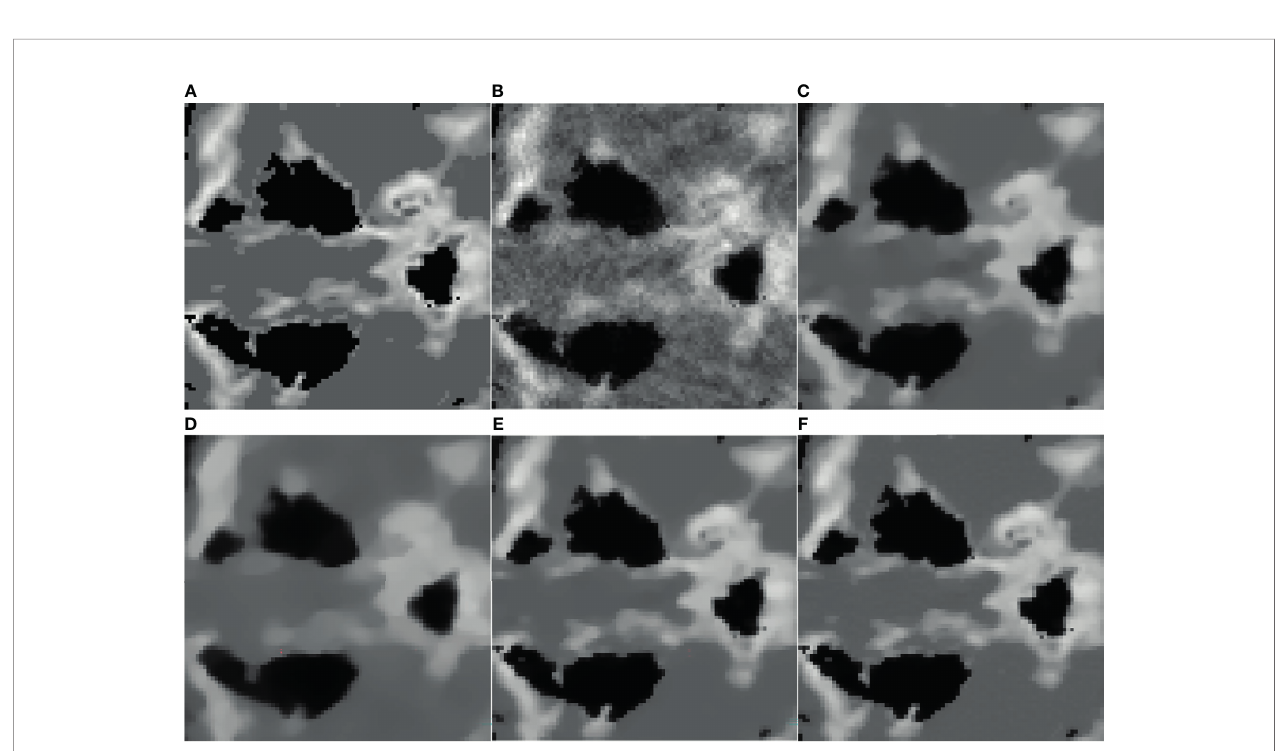
FIGURE 2 | ROI area enlargement result: (A) real graphics; (B) SART; (C) ASD-POCS; (D) SART-TV; (E) TpV; (F)